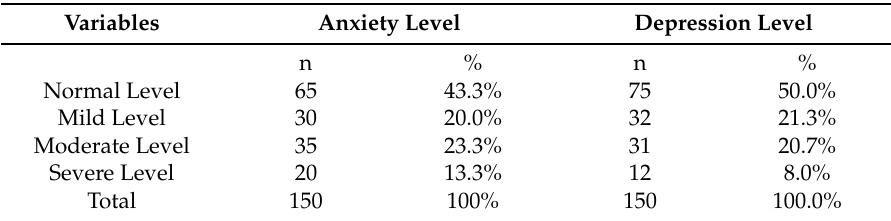
Table 2. Level of anxiety and depression-HADS (N = 150).